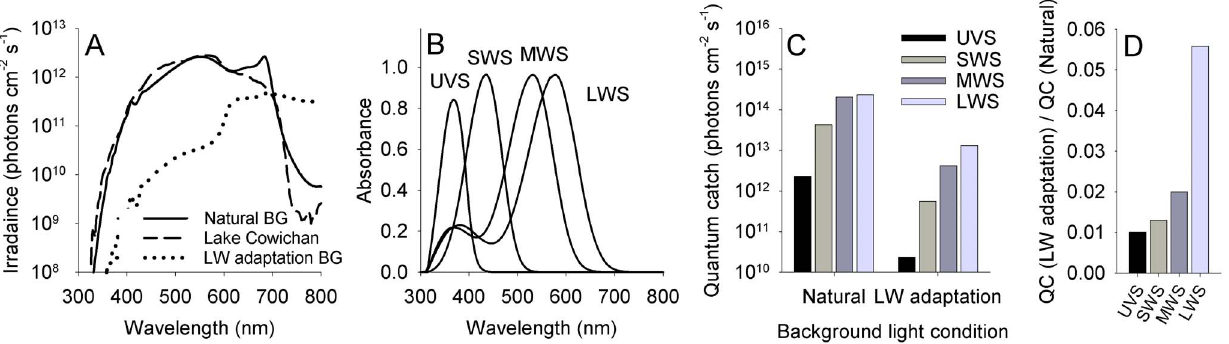
Figure 2. Background illumination conditions, and absorbance spectra and quantum catch of cone pigments in rainbow trout. (A) Two background illumination conditions were used, a broad-spectrum ‘Natural’ background and a long wavelength (LW) adaptation background. The broad-spectrum background simulated the fish natural photic environment by reproducing the sideward irradiance measured at a depth of 3 m at Lake Cowichan, Vancouver Island, BC, Canada (root mean square error=0.38 log photons cm 2 2 s 2 1 ; Pearson r =0.94). The LW adaptation background was designed to dampen the sensitivity of the LWS cone mechanism. (B) Absorbance spectra of the cone pigment classes in rainbow trout. Based on the range of photoreceptor sensitivity, absorbance spectra were constructed while assuming visual pigments are of A1 chromophore. (C) The number of photons collected by the various cone pigment classes under the background conditions used, as estimated using a quantum catch model. (D) The ratio between the quantum catch (QC) of pigments under the LW adaptation and Natural backgrounds was highest for LWS, indicating that LWS is the pigment being adapted most extensively under the LW adaptation compared to the Natural background.